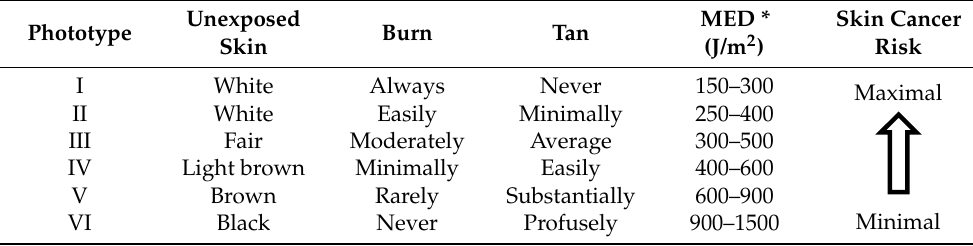
Table 1. Fitzpatrick’s phototype scale, skin type, and risks.